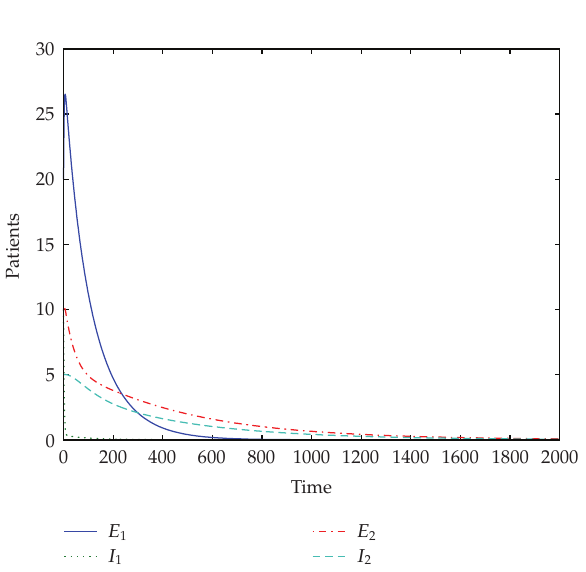
√ 1 (cid:9) 2 bN (cid:3)